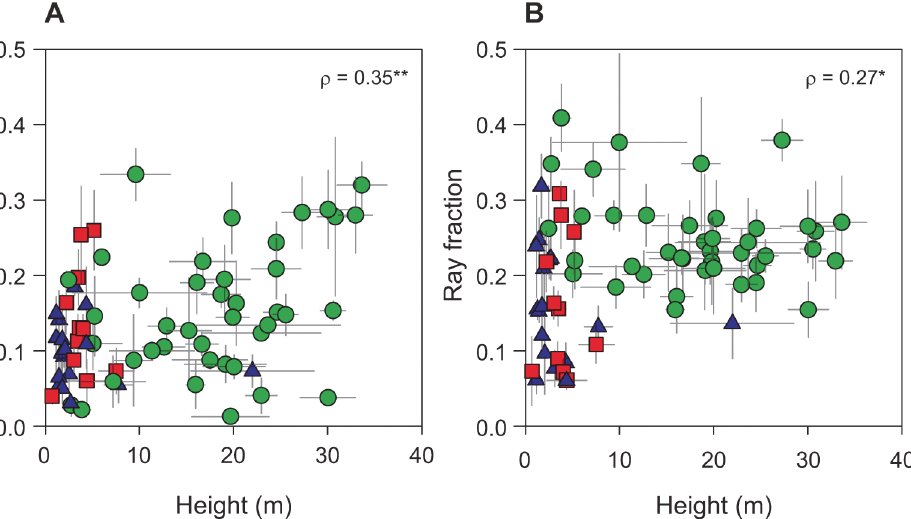
Fig 7. Relationship between axial and ray parenchyma fractions and height. Green circles — tropical rainforest (warm and wet site); red squares — tropical woodland (warm and dry site); blue triangles — temperate forest (cool and wet site). * P < 0.05, ** P < 0.01.